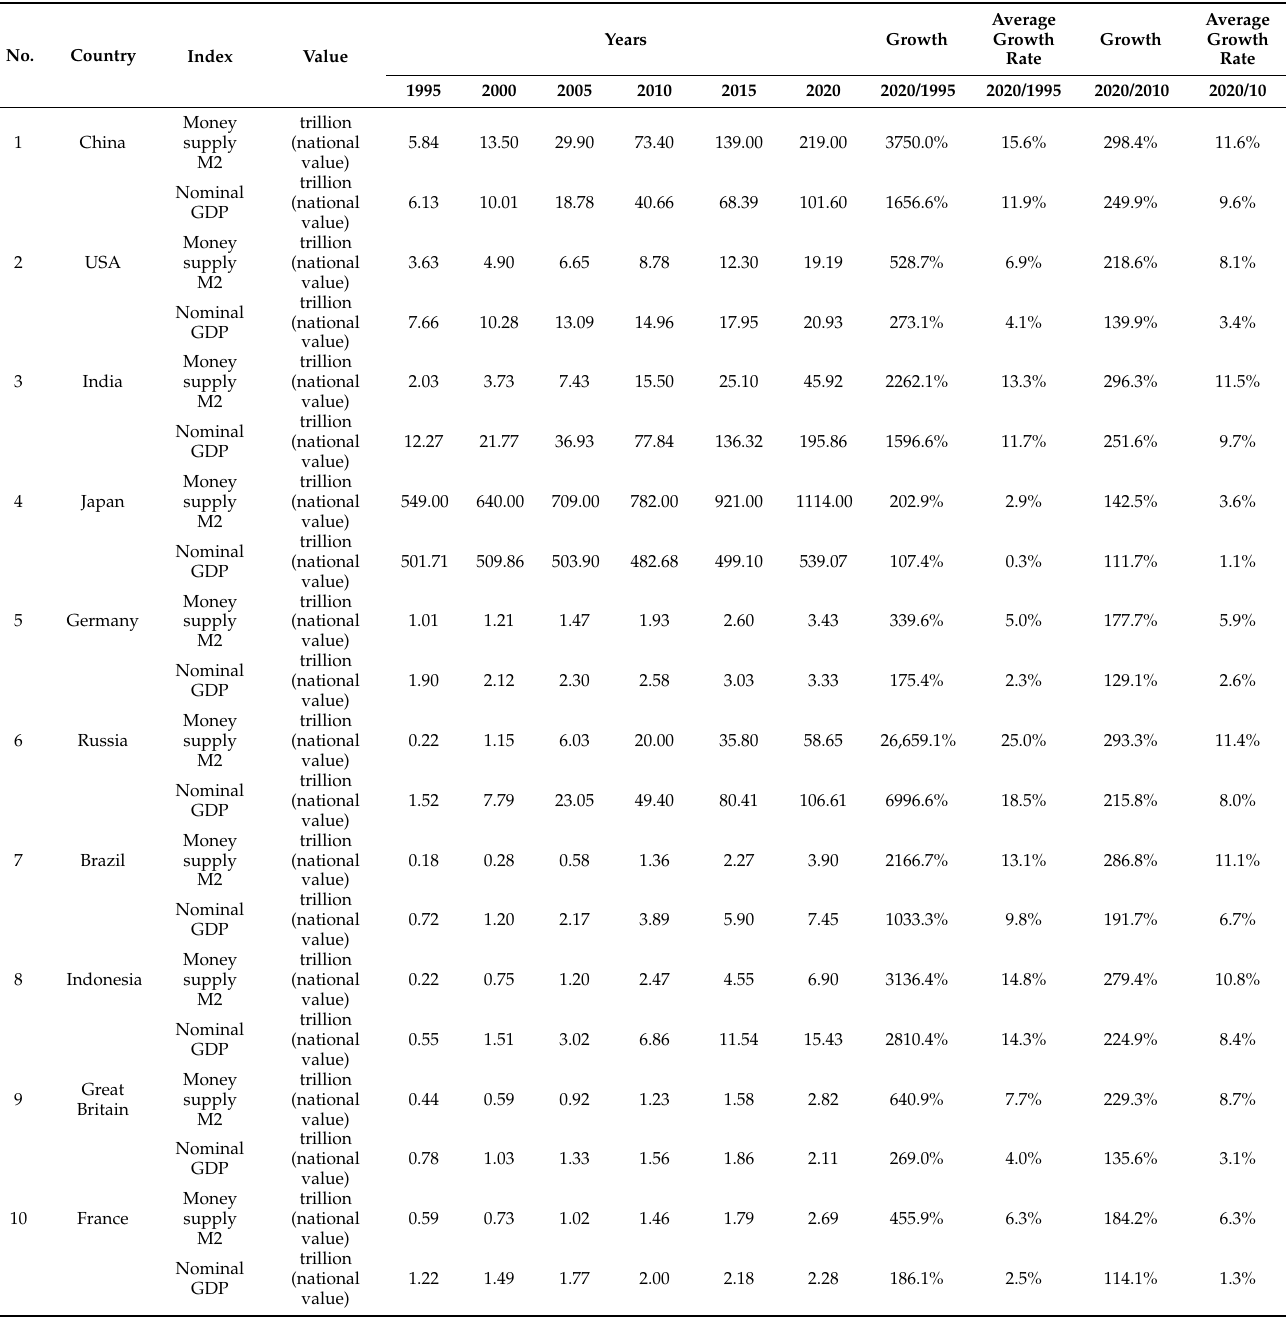
Table 4. Comparative analysis of the dynamics of GDP and money supply (1995–2020) (monetary aggregate M2),